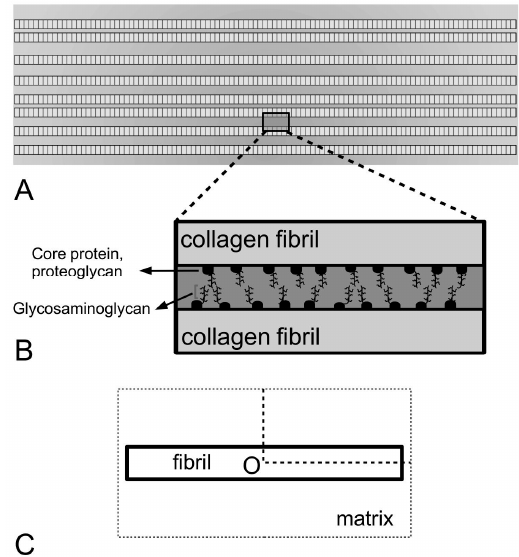
Figure 4. General model of collagen fibril in extracellular matrix (ECM). ( A ) An array of parallel collagen fibrils embedded in the ECM. The vertical dard bands and light shades represent the D-periodic patterns. ( B ) Interaction of collagen fibrils in the matrix. Here the interaction is assumed to be aided somewhat by proteoglycans and glycosaminoglycans, although the exact identity of the proteoglycans has yet to be determined. Not shown in this schematic are the glycoproteins. ( C ) A single collagen fibril modelled as a uniform cylinder. The fibril centre, O, defines the origin of the cylindrical polar coordinate system ( r , θ , z ), where the z axis coincides with the axis of the fibril. Of note, the single fibril-matrix model in part C provides the basic “template” for many of the discussions in this review where stress uptake in the fibril is the key concerned (see Figure 7A and Figure 10 A for similar schematics).